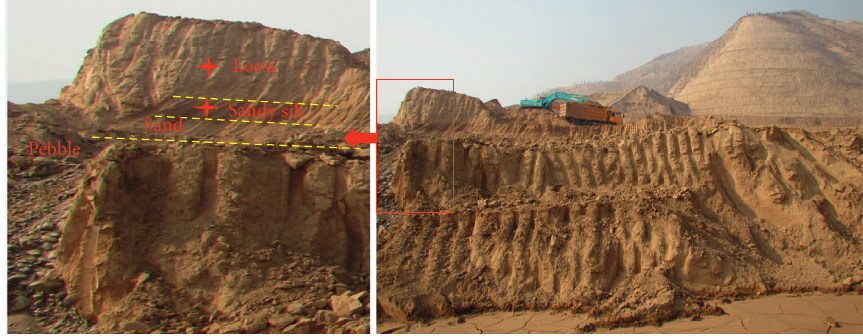
Figure 1: Photograph of sampling site and stratigraphic distribution of loess and sandy